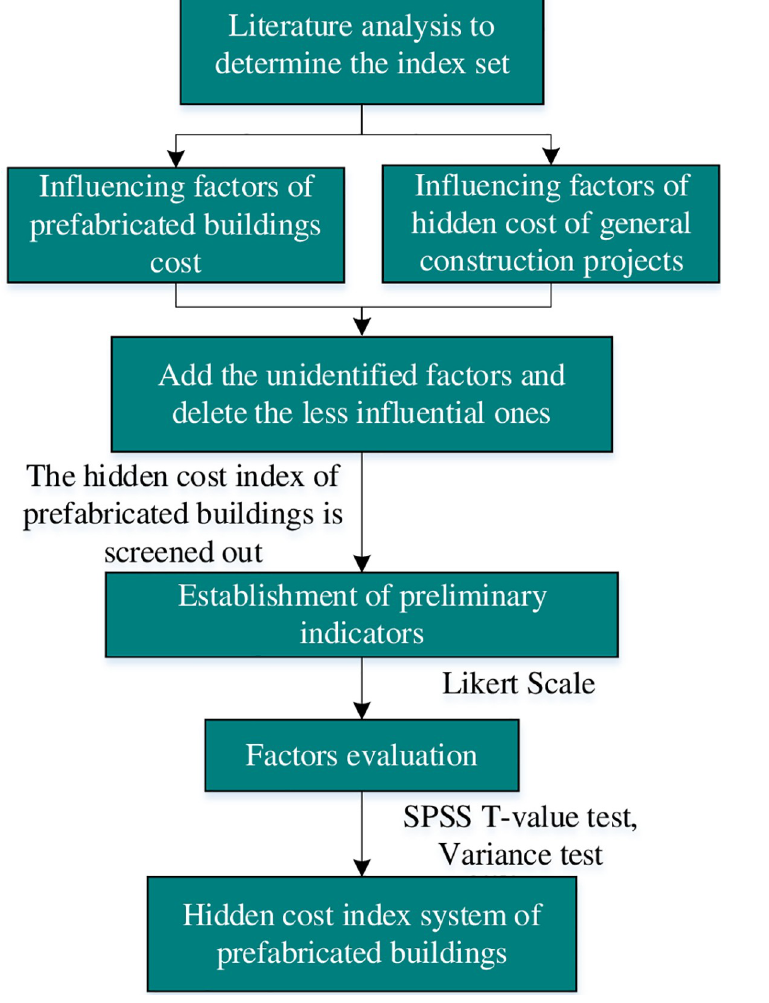
Fig 1. Index system establishment